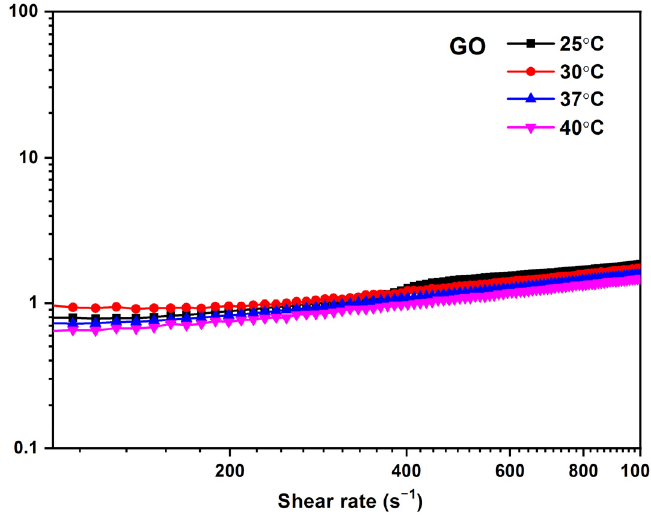
Figure 9. Viscosity ( η ) vs. shear rate ( γ(cid:4662) ) for different temperatures of GO (0.25 mg/mL). Temperature: 37 °C.